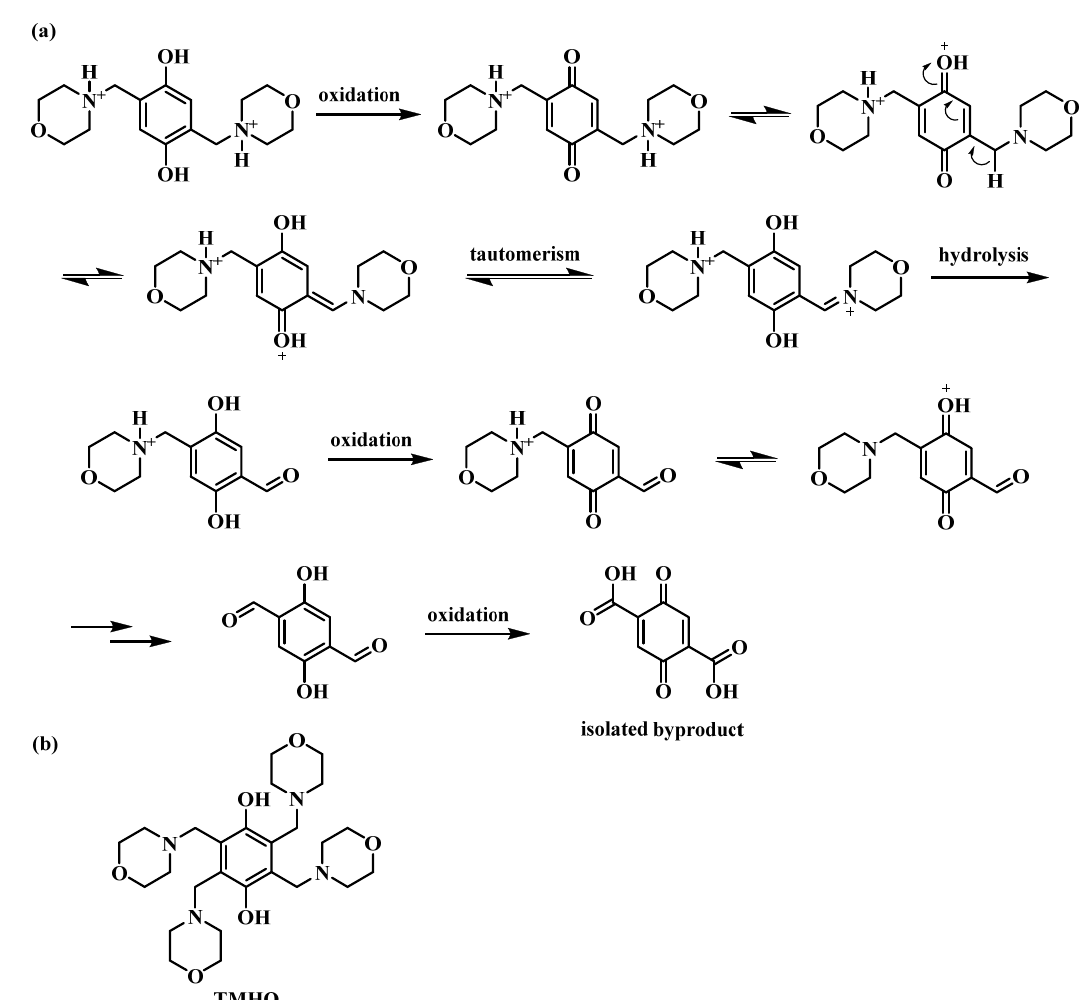
Figure 2. Discharge capacity of the symmetric cells of 0.1 M O-1 , O-3 , O-5 and asym-O-5 in 1 M H 3 PO 4 using the PS cycling method. The y -axis is normalized by dividing the discharge capacity value by its theoretical capacity. The potential is set at 0.3/ − 0.3 V for charge/discharge cycles with cut-off current at 3/ − 3 mA.